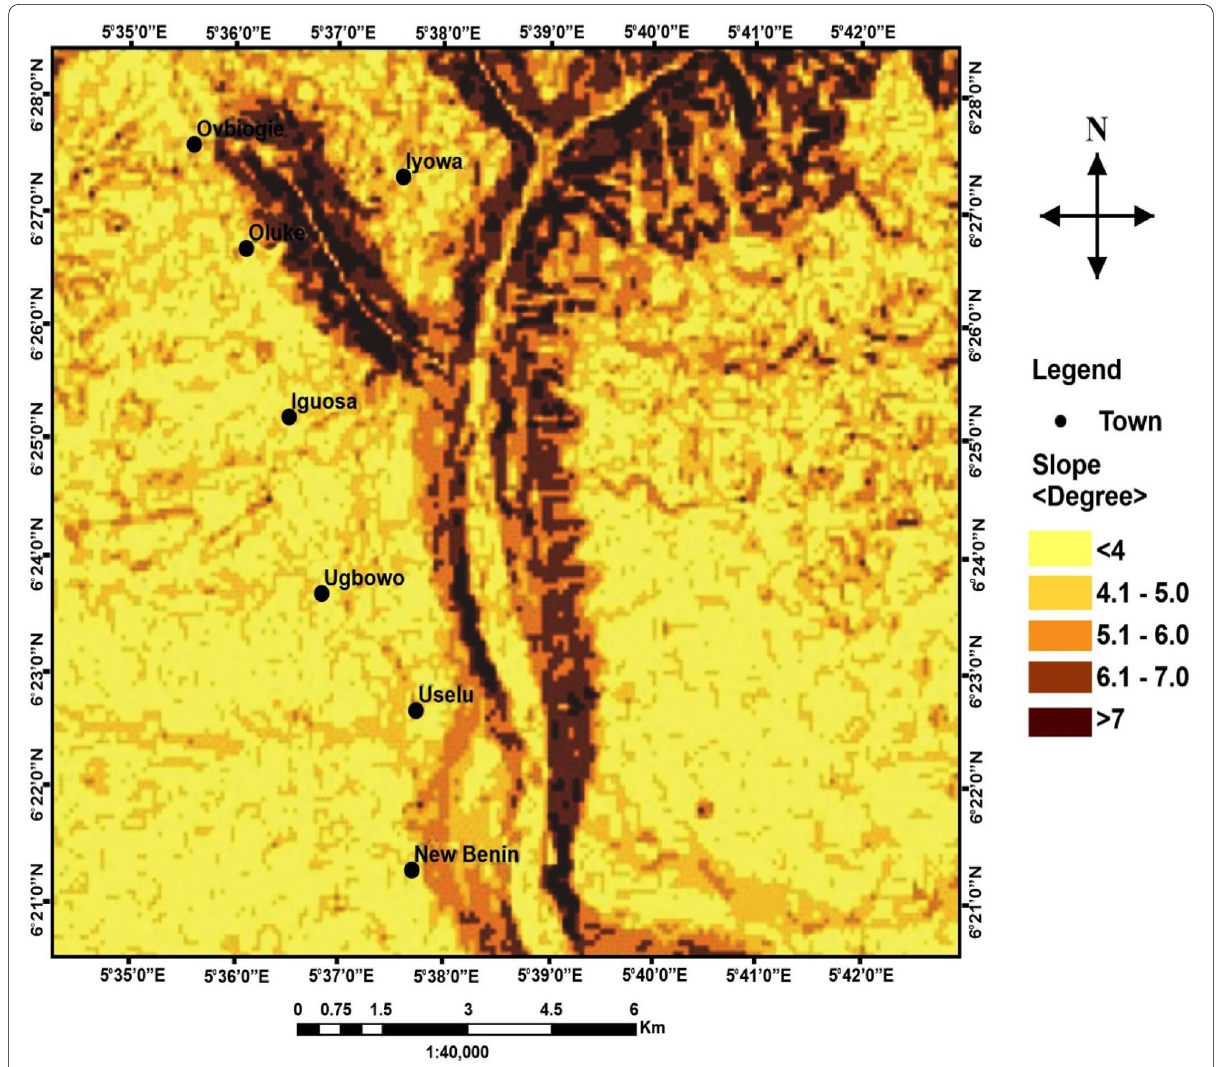
Fig. 3 Slope map of Iguosa and its